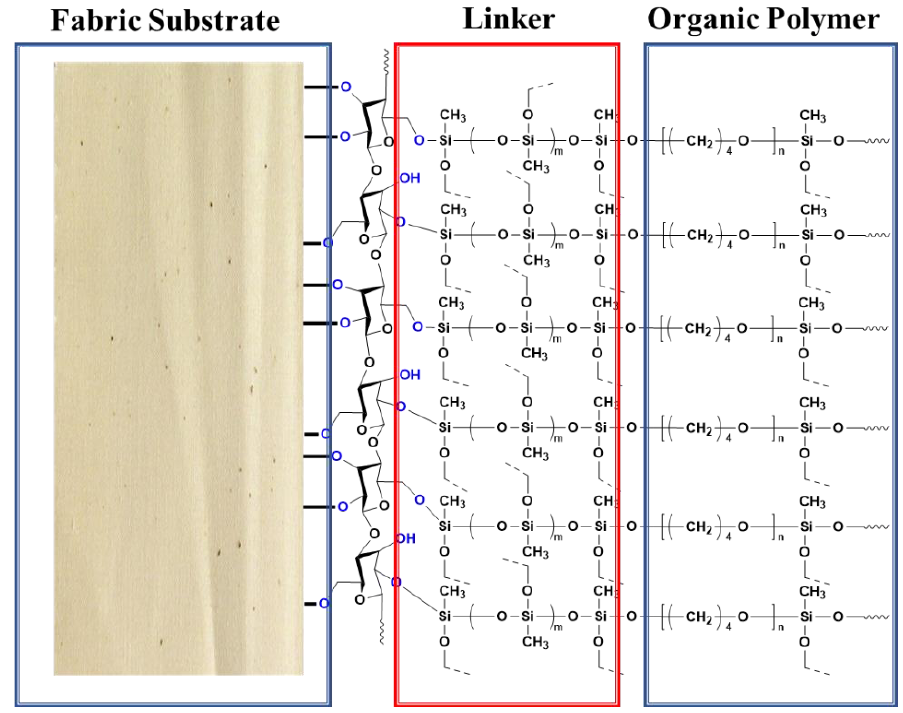
Figure 2. Building blocks of MI-FPSE membrane.